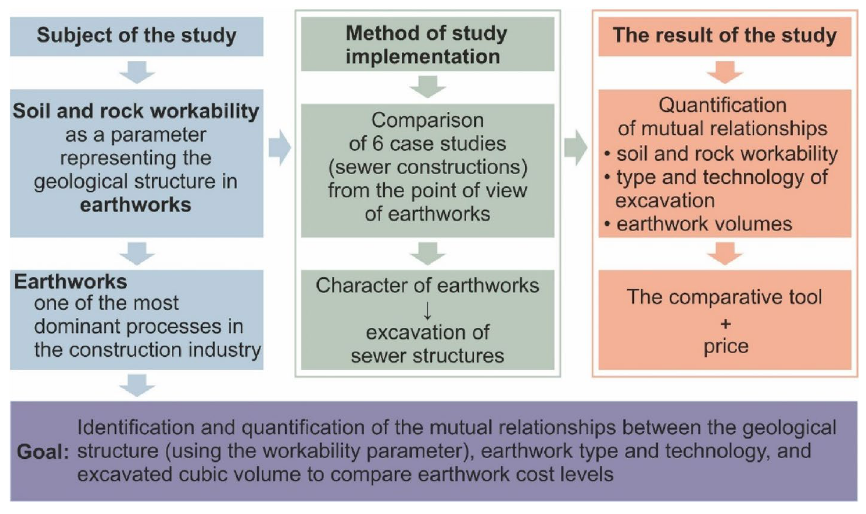
Figure 1. Simplified scheme of the research